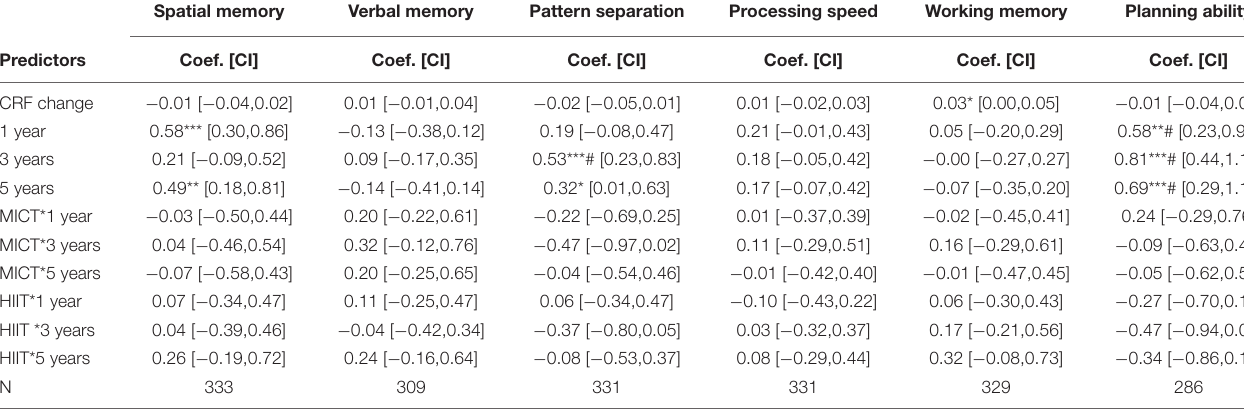
TABLE 7 | Results of the linear mixed model (Model 2) assessing group*time interaction, change in cardiorespiratory fitness, and time effects on cognitive test performance during the intervention in the high intensity interval training group and moderate intensity continuous training group compared to the control group.